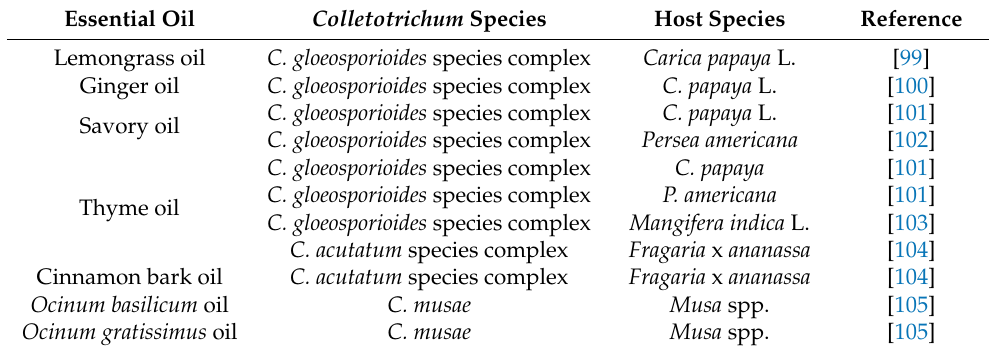
Table 2. Representative essential oils agents for Colletotrichum spp. management in